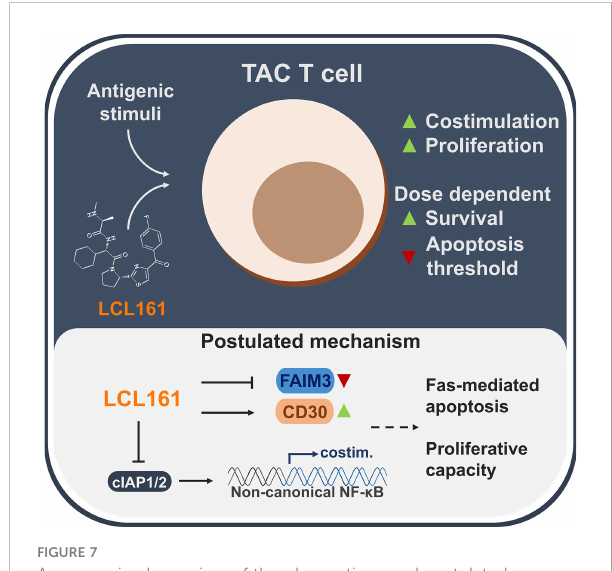
FIGURE 7 A summarized overview of the observations and postulated mechanisms of LCL161-effects on TAC T cell